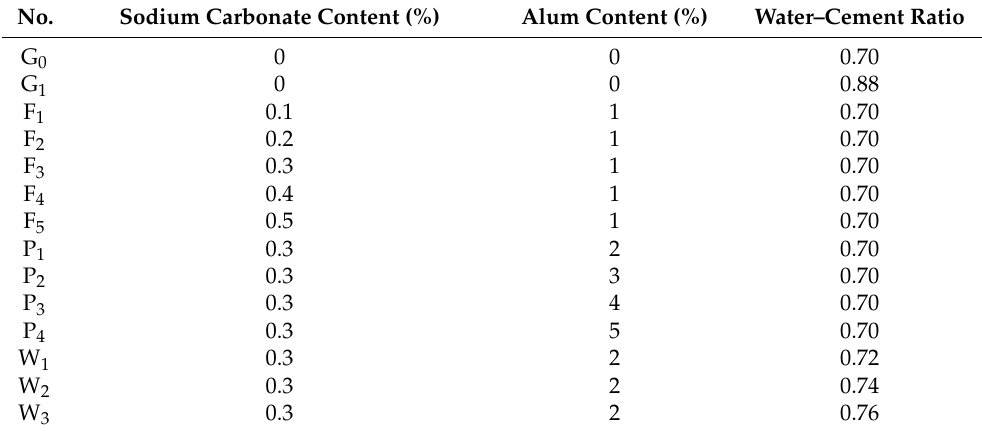
Table 1. Contents of sodium carbonate, alum, and water–cement ratios in sample preparation.